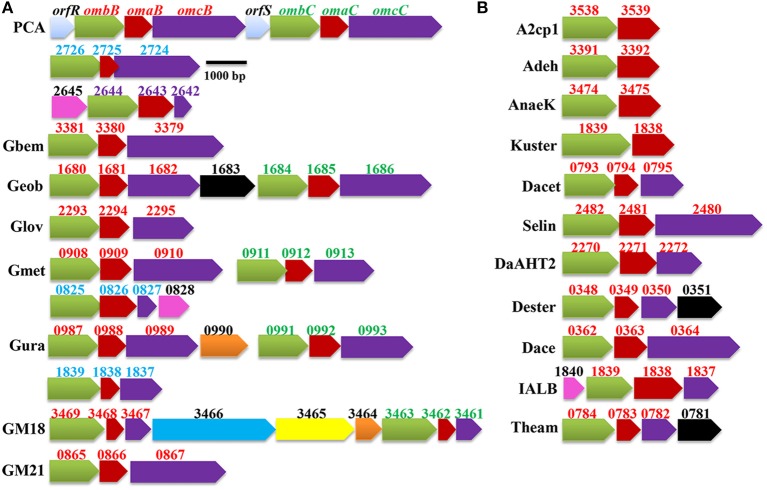
Identified pcc gene cluster in Geobacter spp. (A) and other bacteria (B). The genes encoding different type of proteins are labeled with different colors: green/the Pcc porin-like outer-membrane proteins; red/the Pcc periplasmic c-type cytochromes (c-Cyts); purple/the Pcc outer-membrane c-Cyts; black/the cytoplasmic membrane c-Cyts; pink/the periplasmic c-Cyts; yellow/the porin-like outer-membrane c-Cyt; light blue/transcriptional factors; dark blue/chitinase and orange/hypothetic proteins. The numbers displayed above the gene clusters are part of their locus tags whose letter parts are displayed at left side of the gene clusters with exception that PCA is displayed for the gene clusters identified from G. sulfurreducens PCA. The numbers for the pcc genes are in red, green, blue or purple, while the numbers for the gene associated with pcc genes are in black. Gbem: Geobacter bemidjiensis Bem; Geob: Geobacter sp. FRC-32; Glov: Geobacter lovleyi SZ; Gmet: Geobacter metallireducens GS-15; Gura: Geobacter uraniireducens Rf4; GM18: Geobacter sp. M18; GM21: Geobacter sp. M21; A2cp1: Anaeromyxobacter dehalogenans 2CP-1; Adeh: A. dehalogenans 2CP-C; AnaeK: Anaeromyxobacter sp. K; Kuster: Candidatus Kuenenia stuttgartiensis; Dacet: Denitrovibrio acetiphilus DSM 12809; Selin: Desulfurispirillum indicum S5; DaAHT2: Desulfurivibrio alkaliphilus AHT2; Dester: Desulfurobacterium thermolithotrophum DSM 11699; Dace: Desulfuromonas acetoxidans DSM 684; IALB: Ignavibacterium album JCM 16511; and Theam: Thermovibrio ammonificans HB-1.